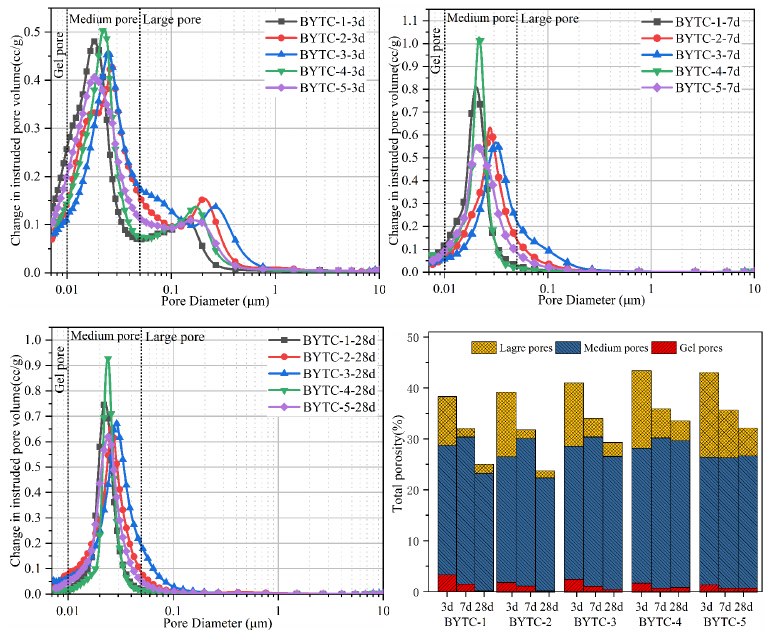
Figure 11. Porosity distribution of blends after 3 d, 7 d and 28 d of hydration. Note: the y-axis scale is different.